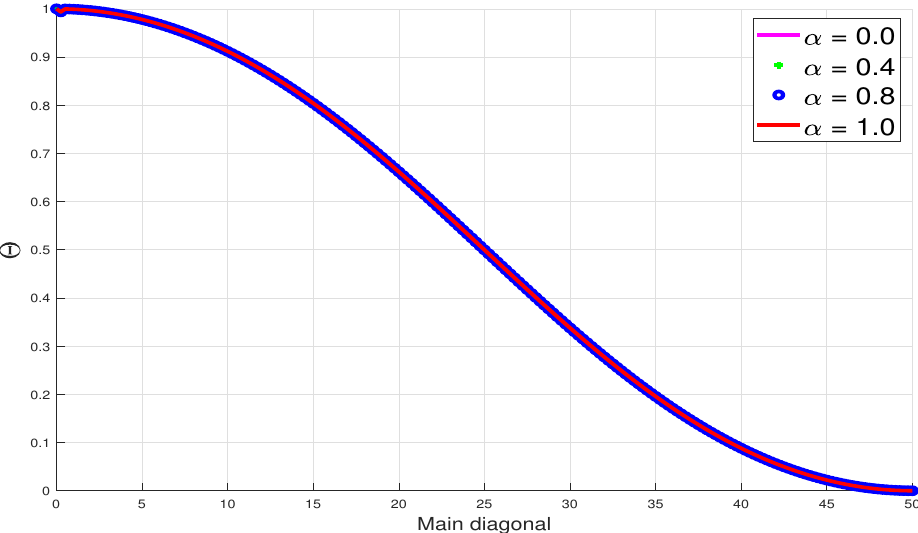
Figure 16. Temperature dependence on α at t =